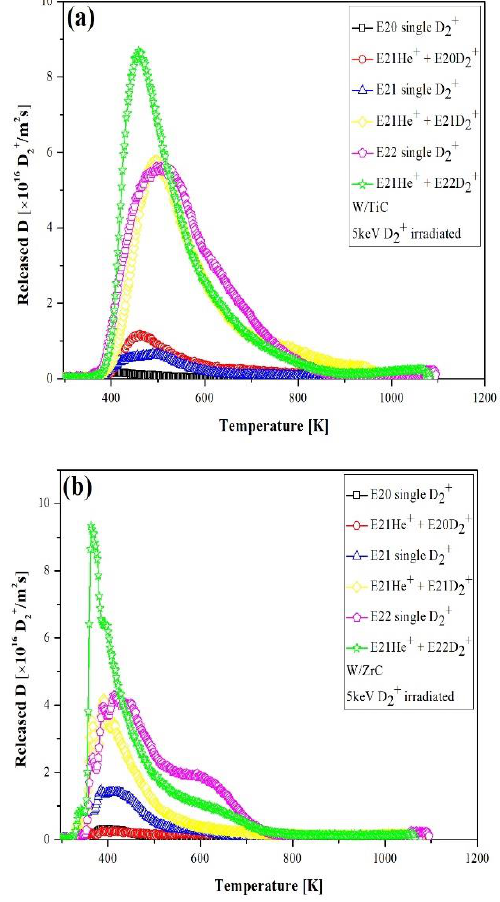
Figure 9. D 2 TDS spectra as a function of temperature in both materials type implanted with various fluences of D 2+ ions after pre-irradiation by 5 keV 1.0 × 10 21 He + /m 2 at RT: ( a ) W-1wt%TiC, ( b ) W-1wt%ZrC.